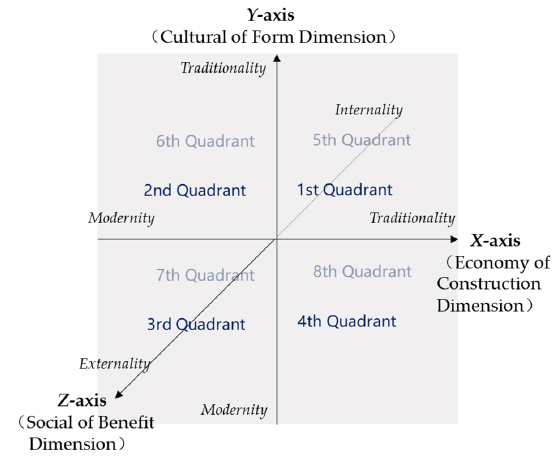
Figure 4. Three ‐ dimensional Evaluation coordinate system diagram. Figure 4. Three-dimensional Evaluation coordinate system